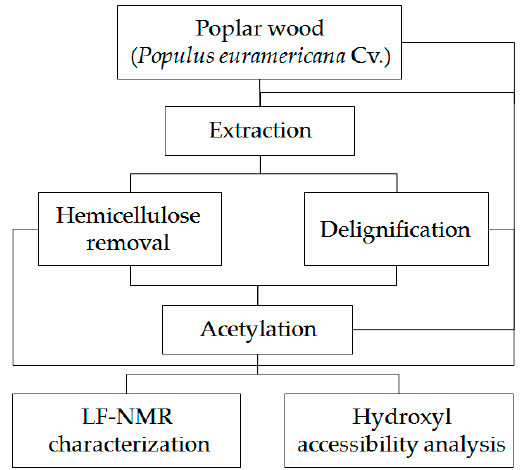
Figure 1. Schematic diagram of the general experimental design.